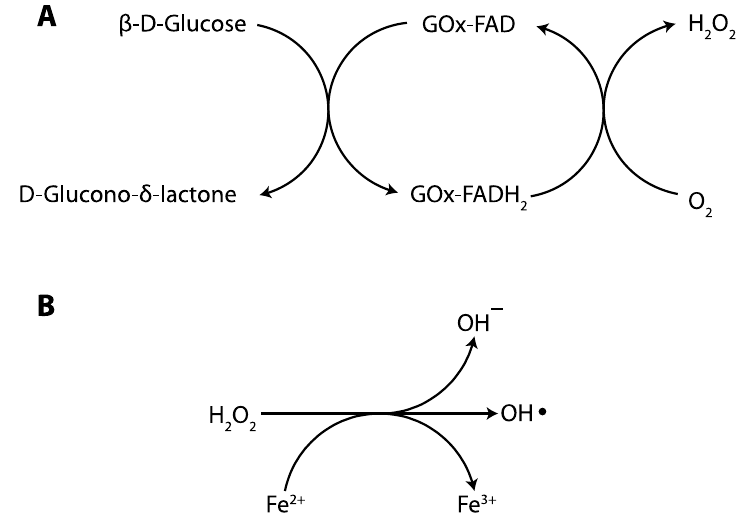
Figure 4. ( A ) Glucose oxidase catalyzes the reduction of oxygen and oxidation of glucose into hydrogen peroxide and gluconolactone, respectively [49]; ( B ) Hydrogen peroxide is readily converted to hydroxyl radicals via the Fenton Reaction with Fe 2+ ions [38–40]. Arrows show reaction direction.